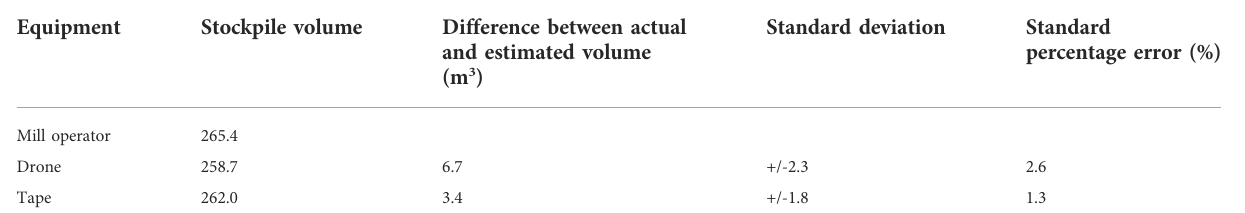
TABLE 5 Comparative analysis of tape and drone volumetric computation.